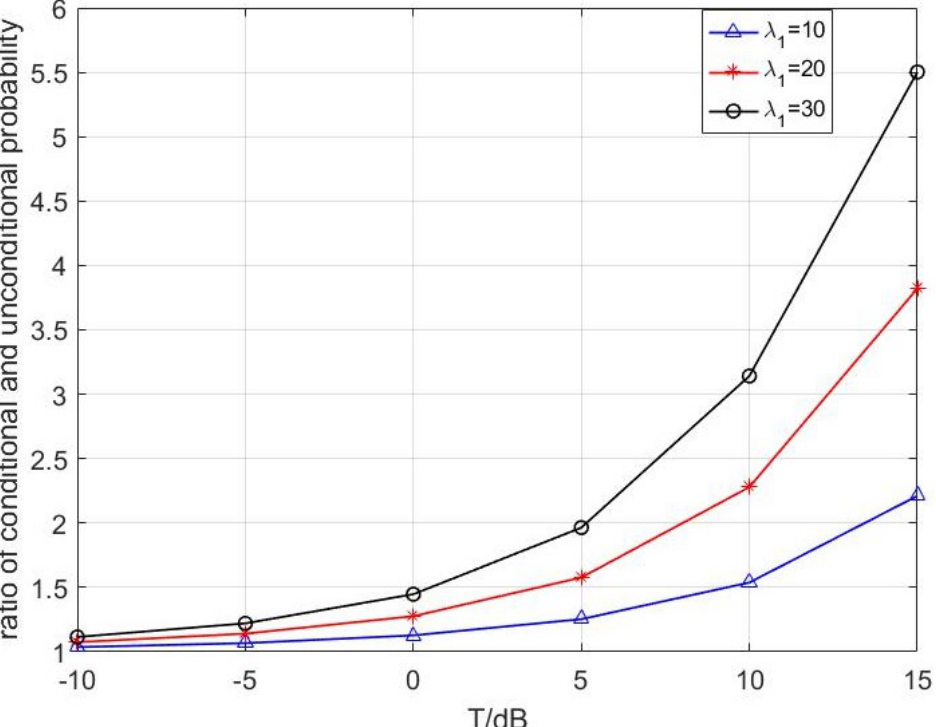
Figure 4. The ratio of conditional probability of Theorem 1 and unconditional probability v.s. T ( dB ) with ρ 1 = 0.8 and ρ 2 = 0.1.